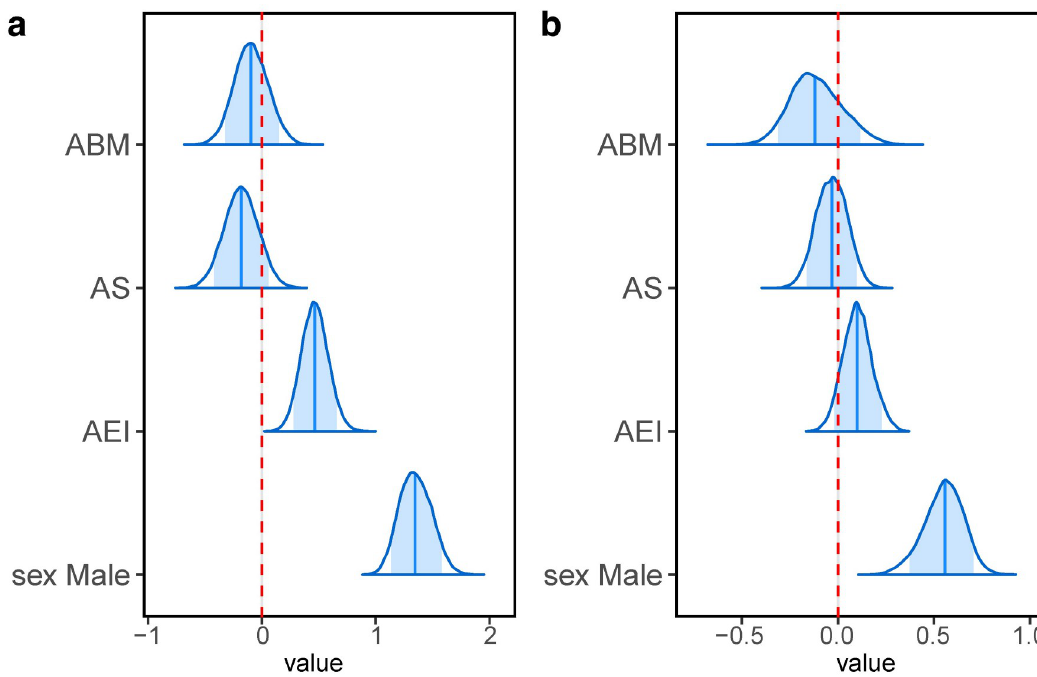
Fig 3. Estimated posterior densities of each parameter in the continuous model. 95% of posterior distributions are drawn here. Edges of distributions indicate the lower bound of 2.5% and upper bound of 97.5%. The dark blue vertical lines indicate the median. The dark blue area in each distribution shows the high density interval (HDI) which includes 89% of samples. The red dashed line indicates